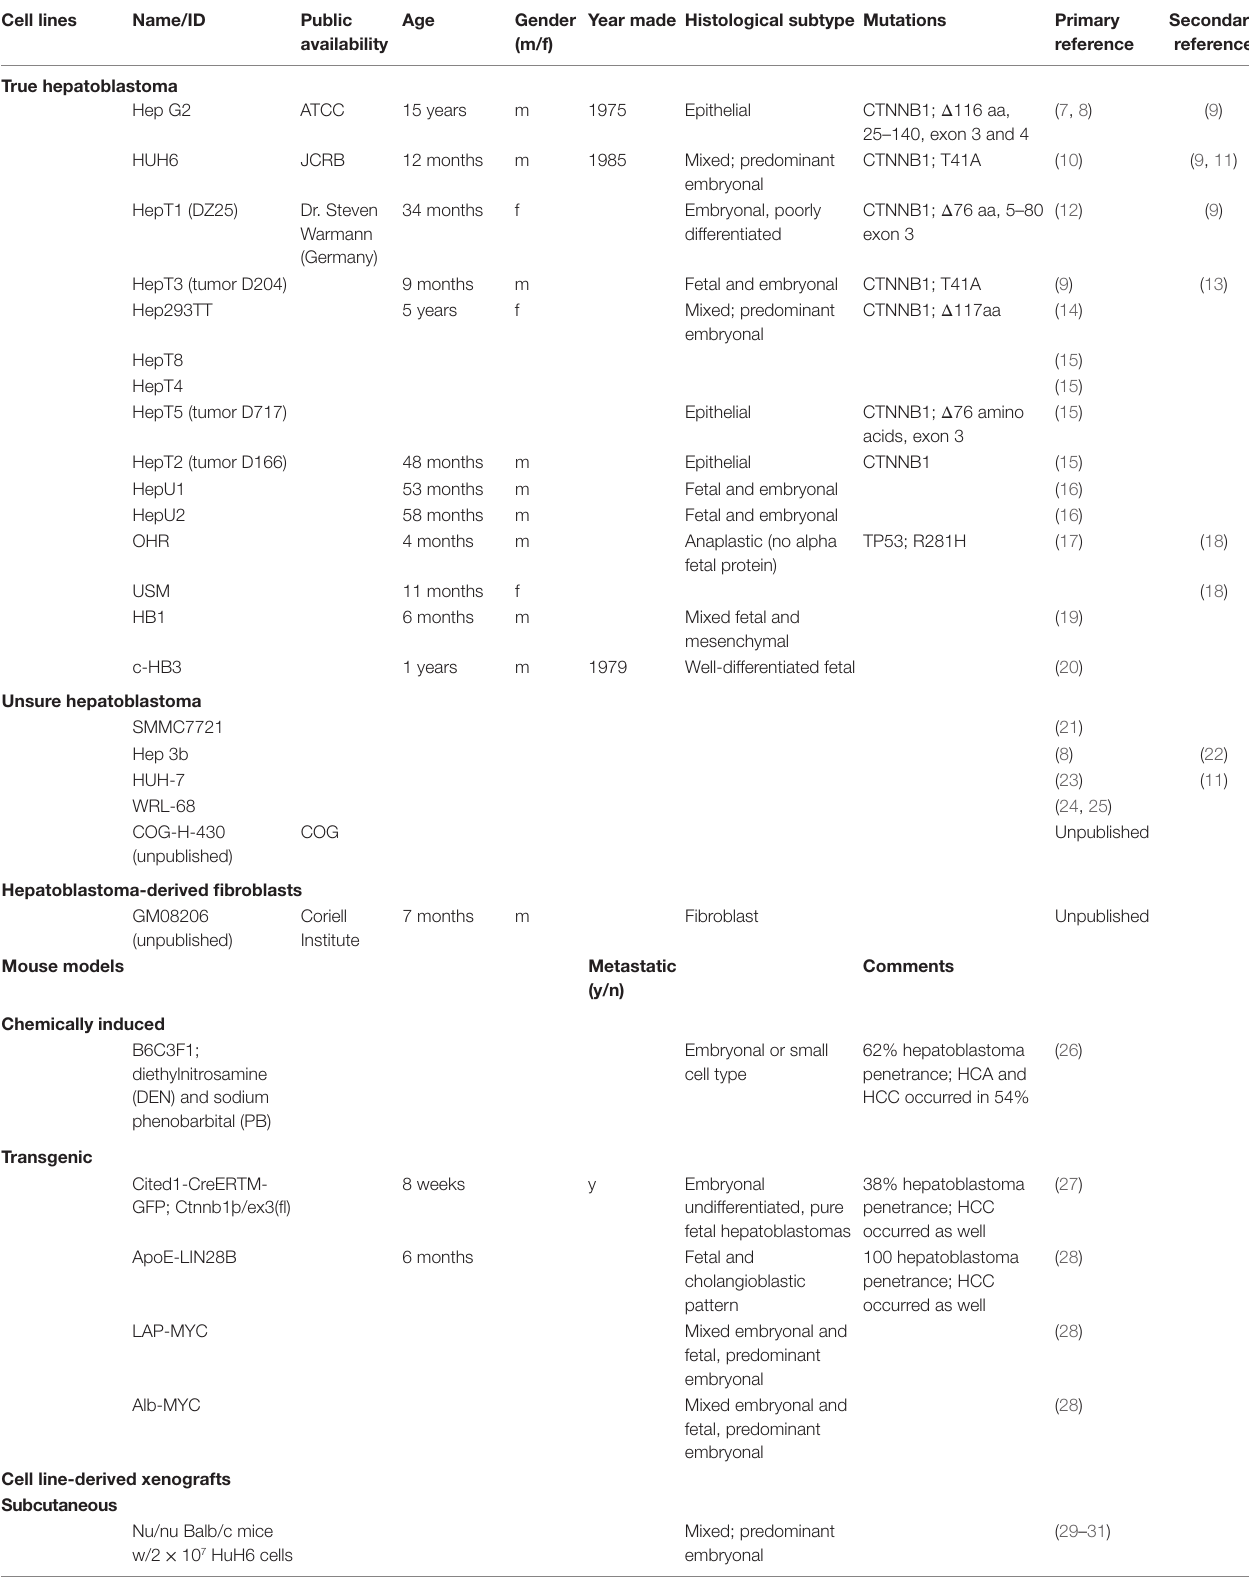
tABLe 1 | Literature review of hepatoblastoma cell lines and mouse models. cell